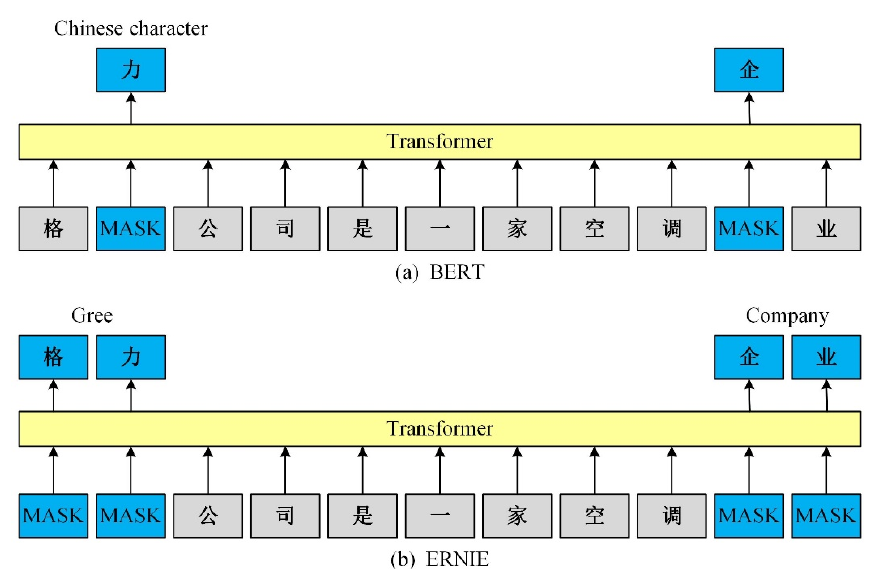
Figure 1. The structure of ERNIE.